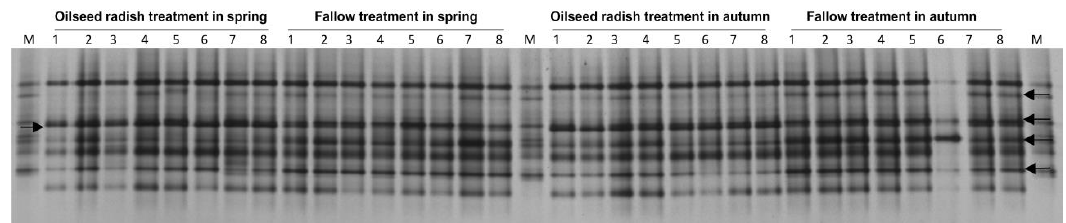
Figure 3. Jeinsen, vap1 gene-based DGGE fingerprints of H. schachtii population from the DNA of 60 pooled cysts per replicate sample (the number above each lane refers to the replicate number for each treatment), and electrophoretic separation by DGGE. M: marker of cloned vap1 variants. The arrows indicate to the different vap1 bands in their intensities between oilseed radish and fallow treatments.